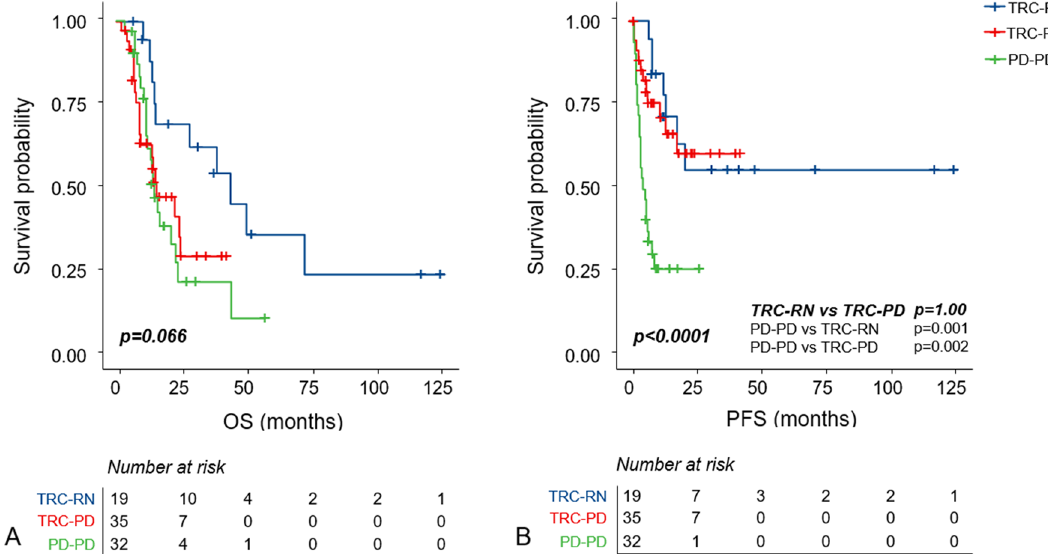
Figure 3. Kaplan–Meier estimate of overall survival ( A ) and progression-free survival ( B ).